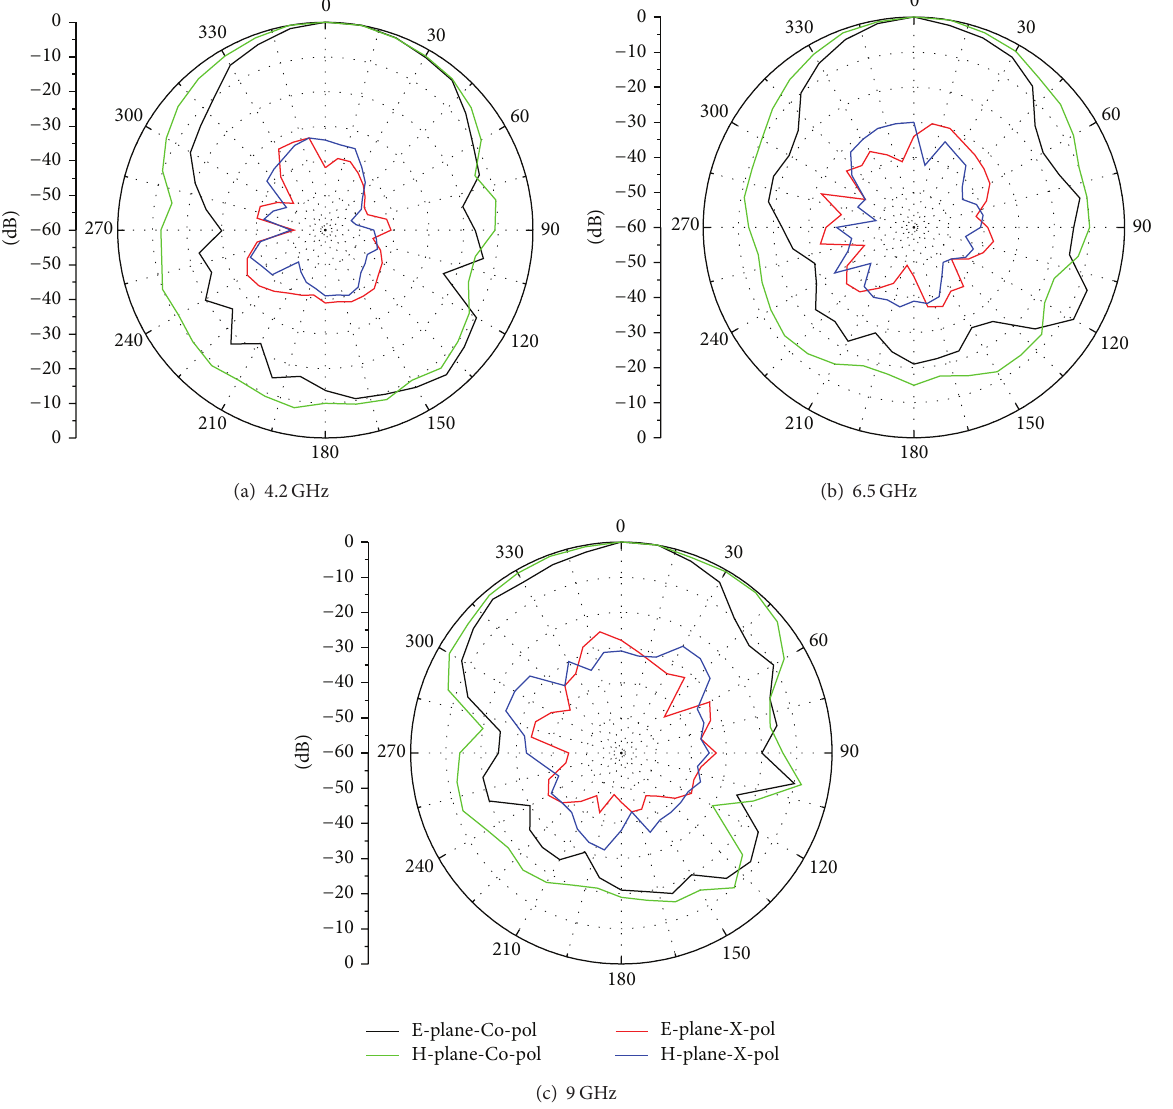
Figure 8: Measured result of radiation pattern.